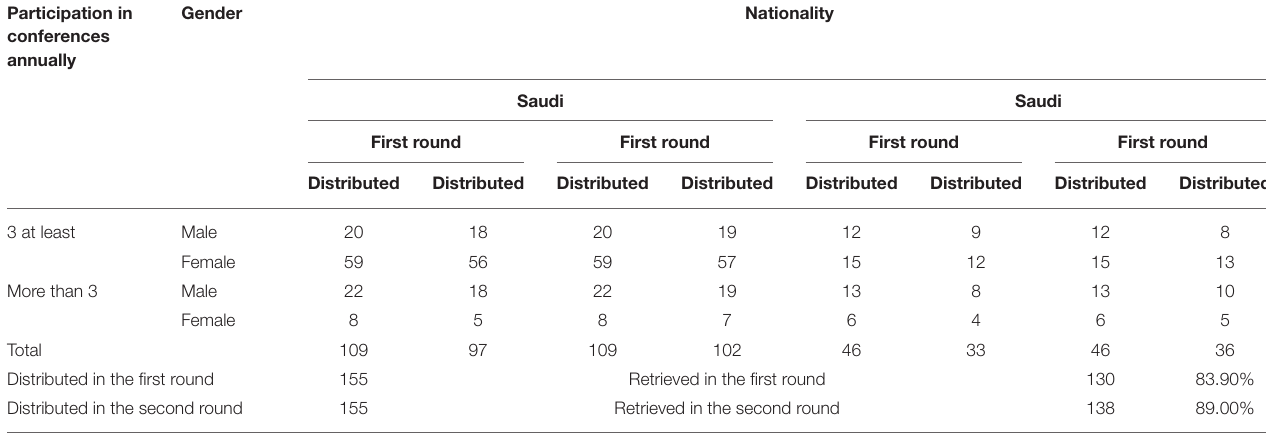
TABLE 1 | Number of copies of the measure distributed and retrieved.